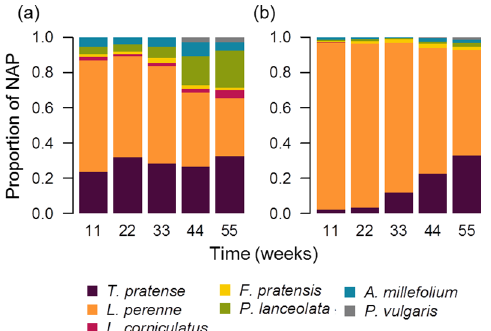
Fig 3. Plant species composition at each harvest with two soil inocula treatments. Plant community composition as represented by the species proportional abundance is shown for (a) the unaltered soil inoculum and (b) the sterilized soil inoculum. Colored bar height indicates the proportion of each plant